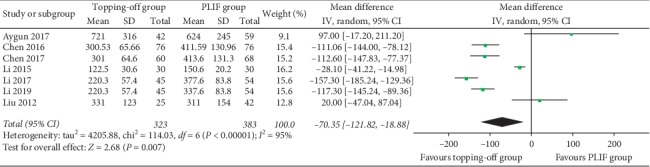
Forest plot of EBL.